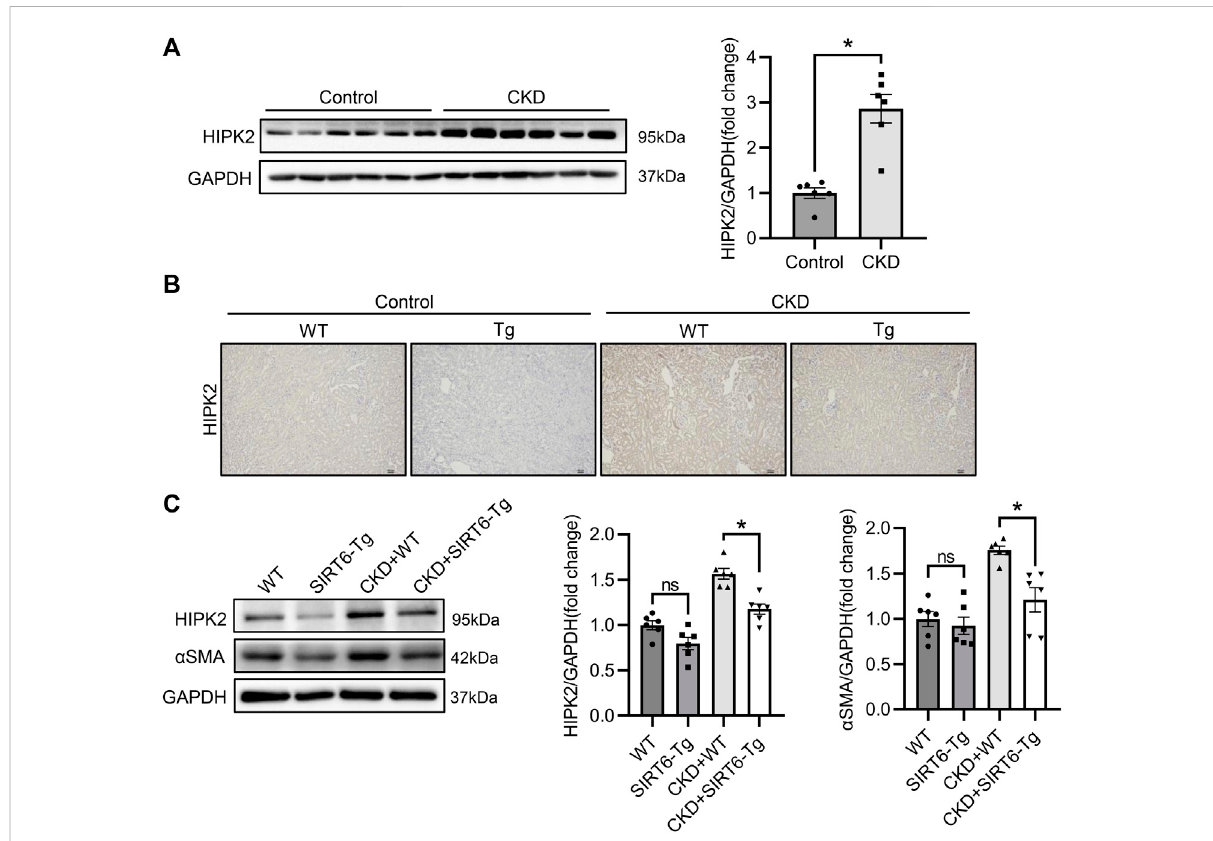
FIGURE 2 HIPK2 wasdownregulated inthekidneysofSIRT6-Tg mice. (A) Westernblotanalysis ofHIPK2expressionin fi brotic kidneysofCKDmice. n =6. (B) Representative immunohistochemical images of HIPK2 in kidneys of SIRT6-Tg mice. Scale bar, 100 μ m. (C) Western blot analysis of HIPK2 and α SMA expression in fi brotic kidneys of WT and SIRT6-Tg mice. n = 6. All values are presented as mean ± SEM. * p <